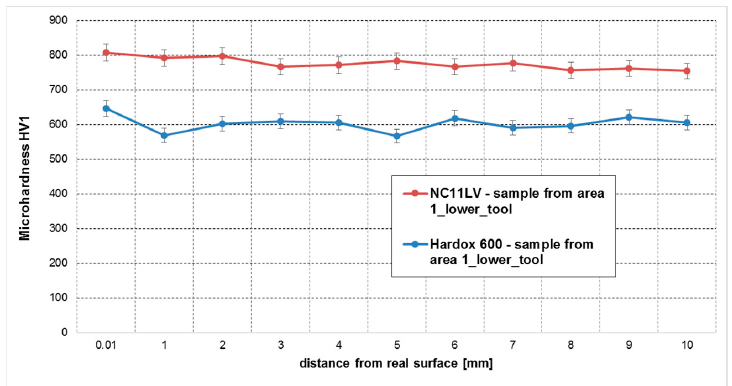
Figure 18. Hardness measurements at a distance from the working surface for area 1 (steels NC11LV and Hardox).